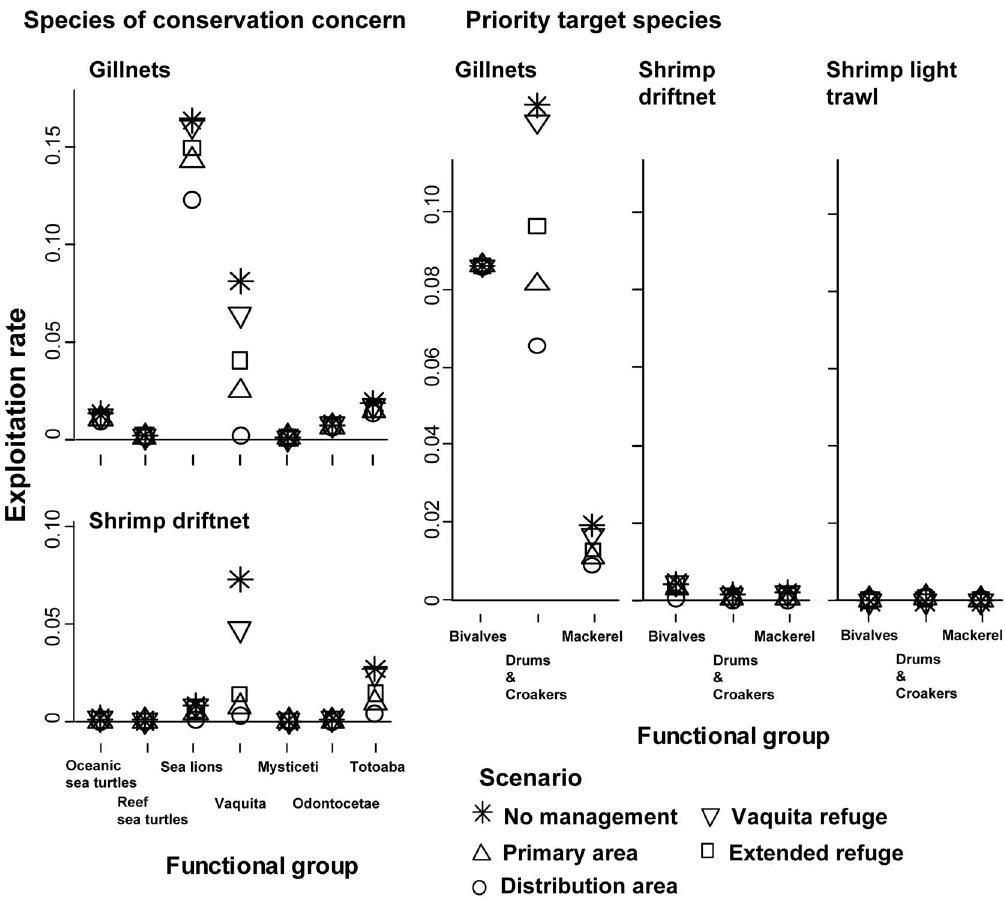
Figure 3. Exploitation rate (catch/biomass) of species of conservation concern and priority target species in the shrimp industrial trawl and shrimp driftnet fleets of the Upper Gulf and the gillnet fleet for the complete model extent. The exploitation rate across scenarios was calculated using catch relative to biomass in 2009.